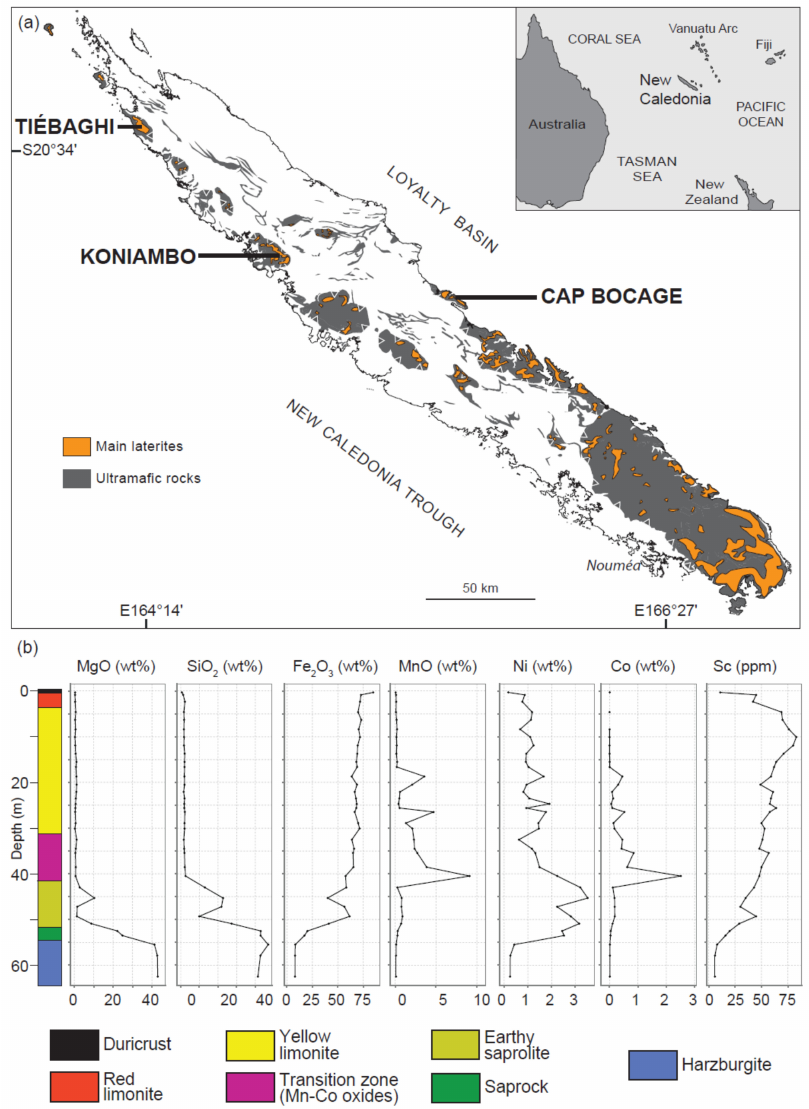
Figure 1. ( a ) Geological map of New Caledonia and location of the investigated mining massifs. Modified from Maurizot and Vend é -Leclerc [29]. ( b ) Geochemical evolution along a typical Ni-lateritic profile in New Caledonia (modified from Bailly et al.